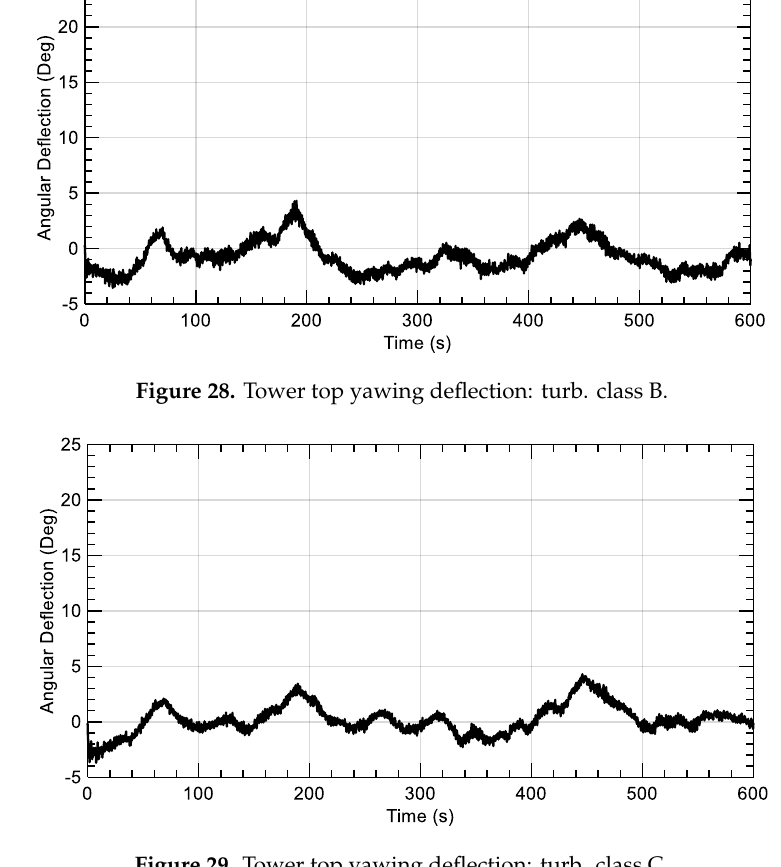
Figure 29. Tower top yawing deflection: turb. class C.